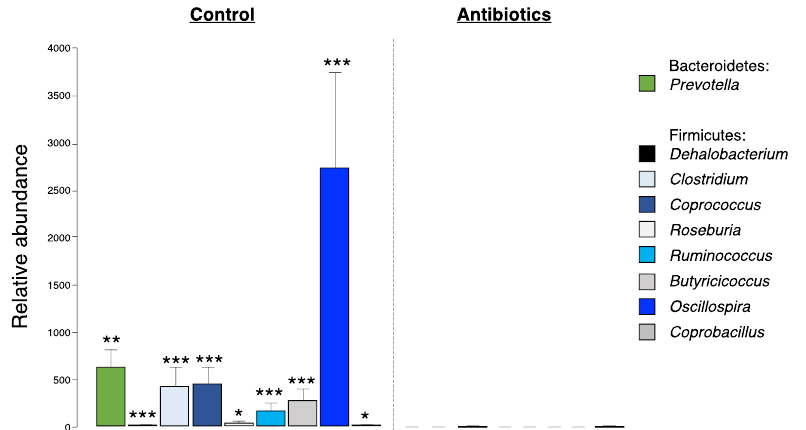
Figure 3. Alpha diversity at the genus level in control and antibiotic-treated males. Relative abun- dance of the genera Prevotella , Dehalobacterium , Clostridium , Coprococcus , Roseburia , Ruminococcus , Butyricicoccus , Oscillospira , and Coprobaccilus in controls and antibiotic-treated animals. Asterisks (*) above bars represent significant differences between controls and antibiotic treatment. Data are collapsed by fecal collection timepoint. Error bars represent S.E.M., *** p < 0.001, ** p < 0.01, * p < 0.05, n = 9 – 14/group.